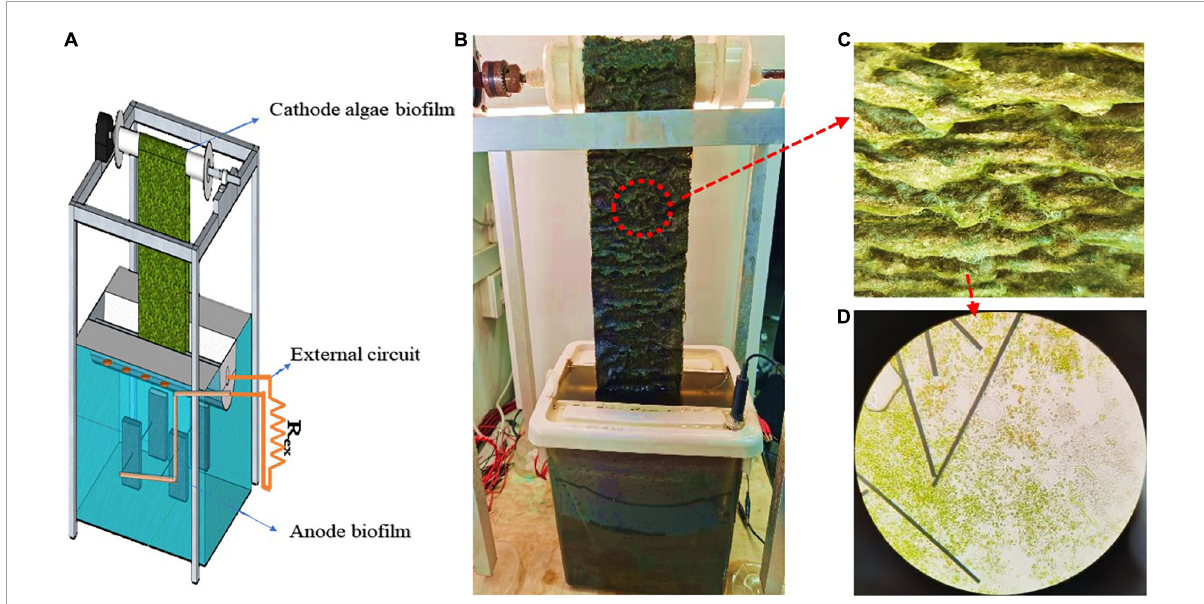
FIGURE1 Schematics of the RAB-MFC system (A) ; the photo of RAB-MFC system (B) ; algae biofilm on the carbon cloth (C) ; and the micrograph of algae biofilm (10 × 40) (D) .